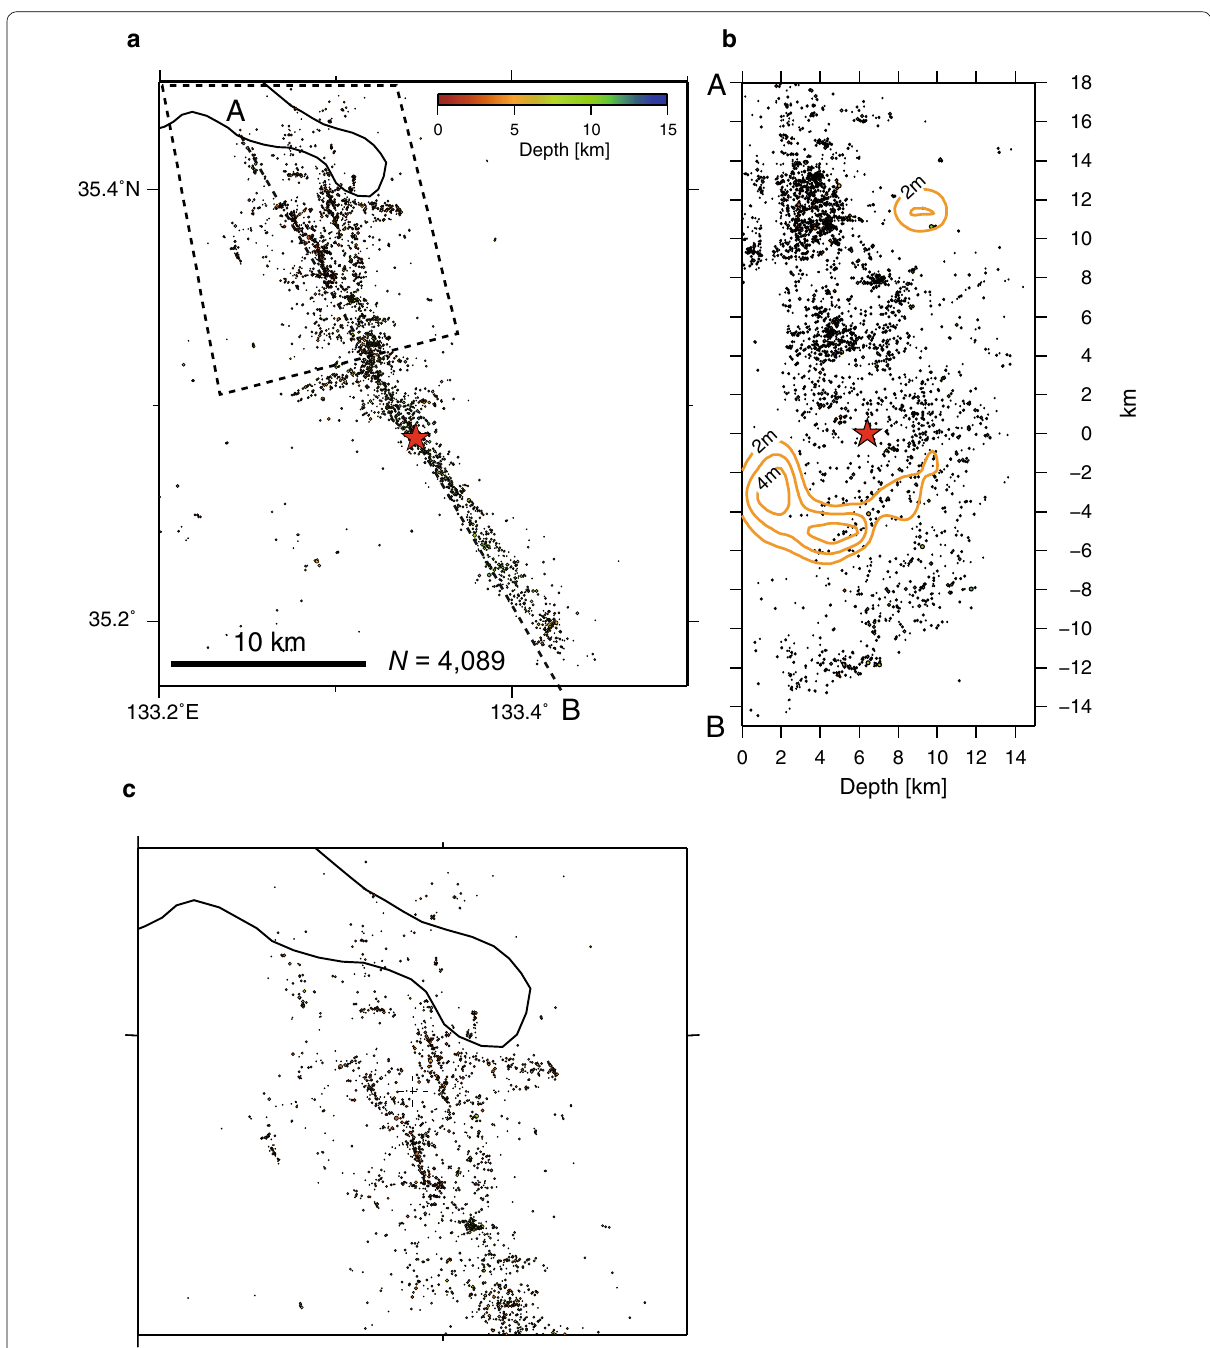
Fig. 2 Hypocenter distribution of the aftershocks determined by the DD method. The depth of the hypocenter is indicated by the color scale . a Epicentral distribution, b depth distribution projected onto line A–B in ( a ), and ( c ) magnified image of the northern part of the aftershock region. Earthquakes within a distance of 6 km from the line are projected in ( b ). The orange contours projected on line A–B in ( b ) indicate areas of large slip exceeding a dislocation of 2.0 m as estimated by Iwata and Sekiguchi (2002). The northern part of the aftershock region is indicated by the area enclosed by the broken line in ( a